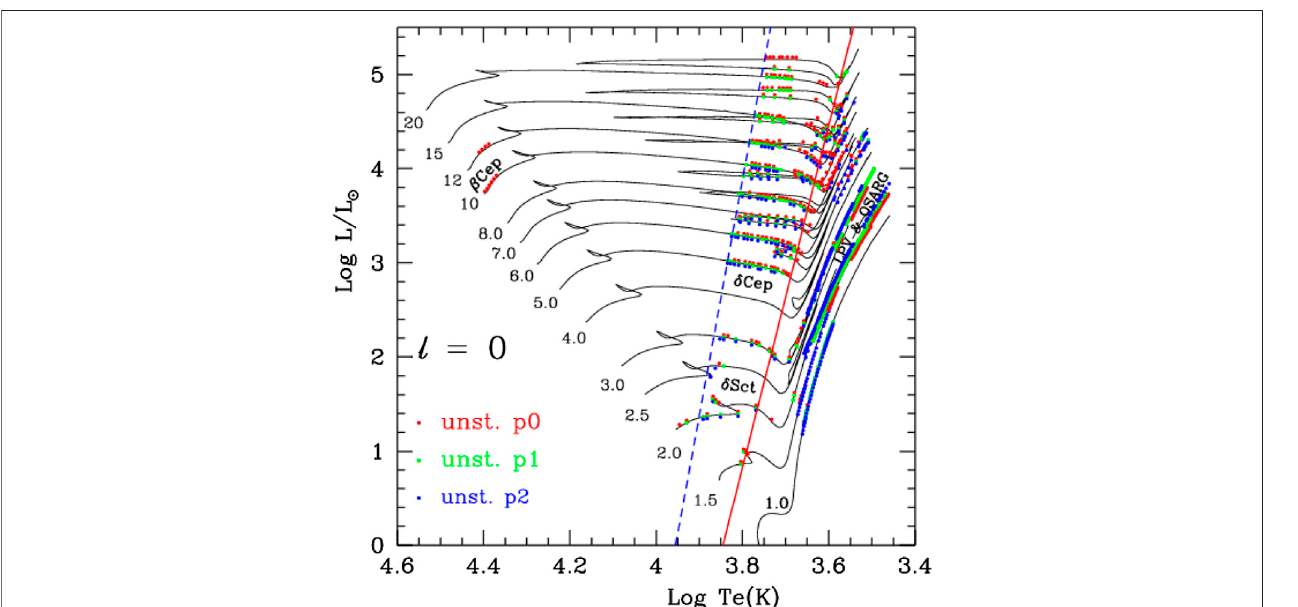
FIGURE5| Pulsationallyunstableradiallow-ordermodes(colored, fi lledcirclesaslabeledinthe fi gure)intheH-Rdiagramforevolutionarymodelsof1 – 20M ⊙ stars. Eachcolorisshiftedaline-widthinthe x -/ y -direction.Thebluedashedlineandredsolidlineare,respectively,ourtheoreticalblueandrededgesoftheCepheidinstability strip. The locations of the main types of variable stars are